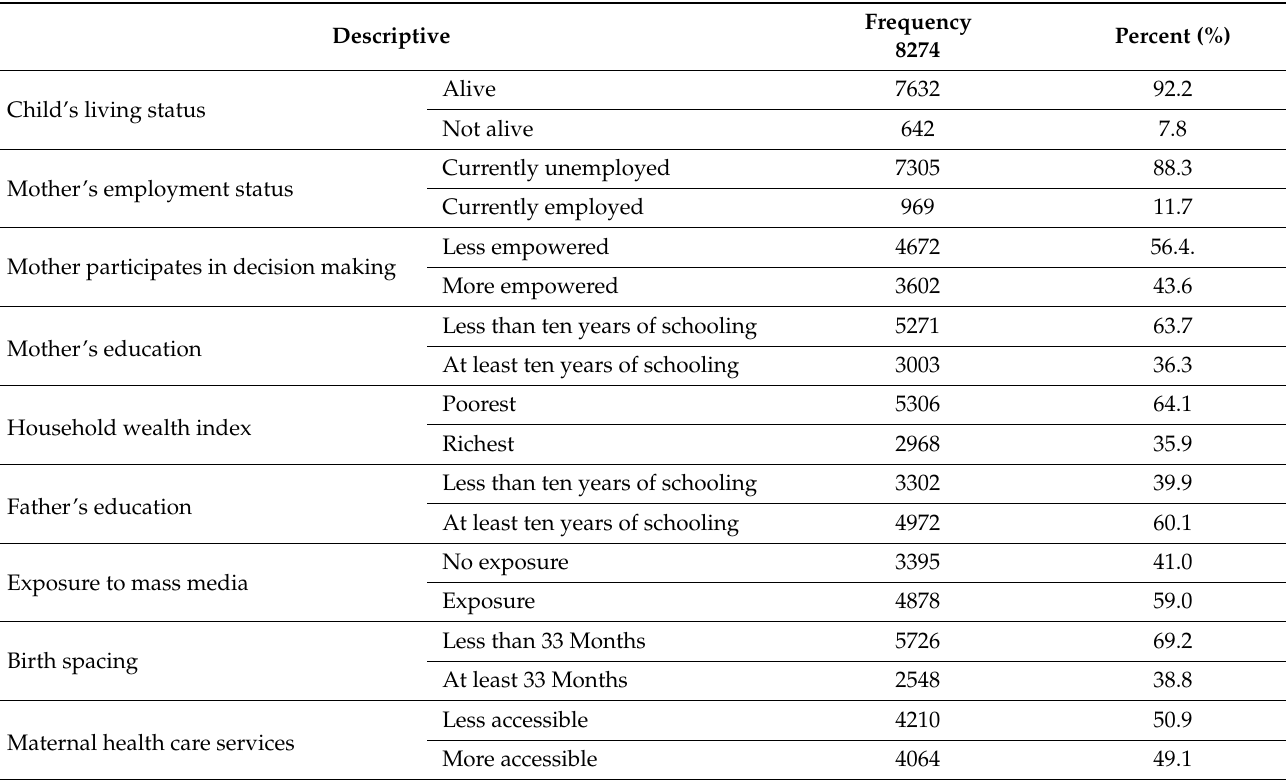
Table 1. Descriptive statistics of different characteristics of